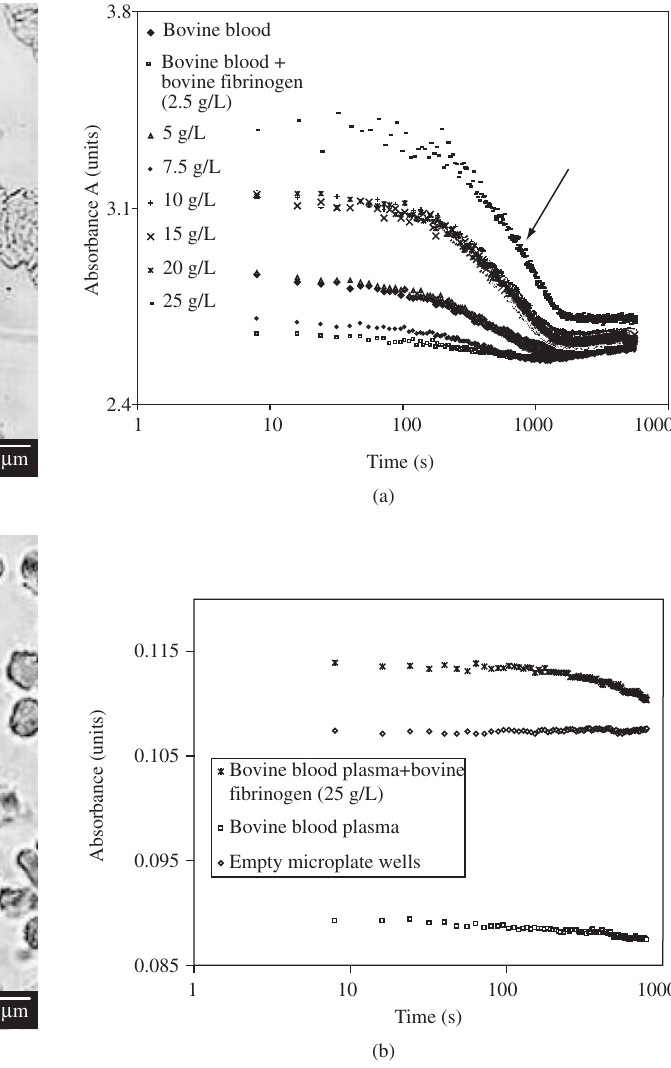
Figure 5. a) Microplate Reader: Total absorption of bovine blood, and absorp- tion with the addition of fibrinogen; and b) fibrinogen did not affect the absorp- tion of samples at the wavelength studied (655 nm). The absorption of plasma was lower than the absorption of empty wells on an empty